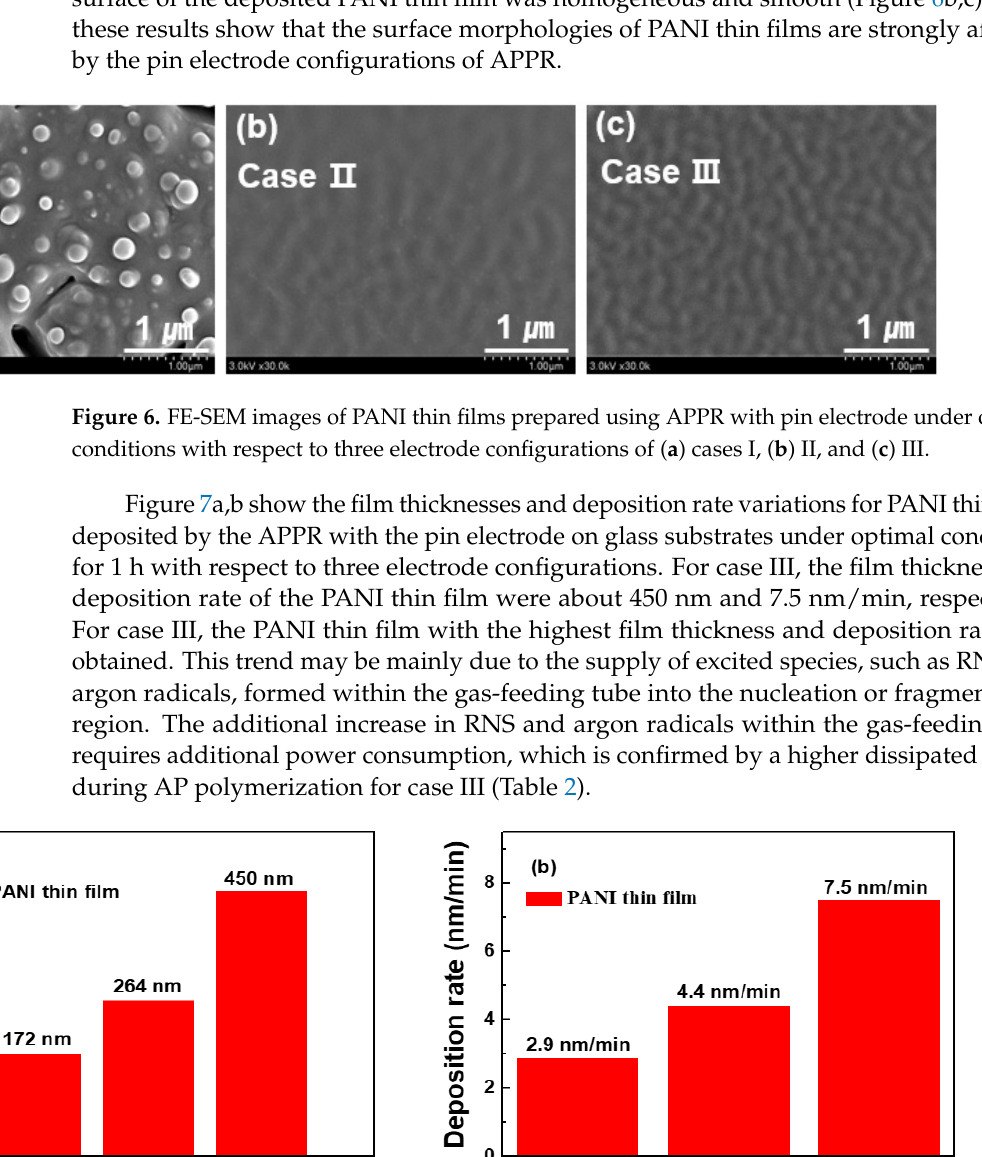
Figure 8. Two − and three − dimensional AFM images of PANI thin films prepared by APPR with pin electrode under optimal conditions with respect to three electrode configurations (cases I, II, and III). Table 3. Root mean square roughness (R rms ) and average roughness (R a ) of PANI thin films obtained from AFM images in Figure 8. Sample